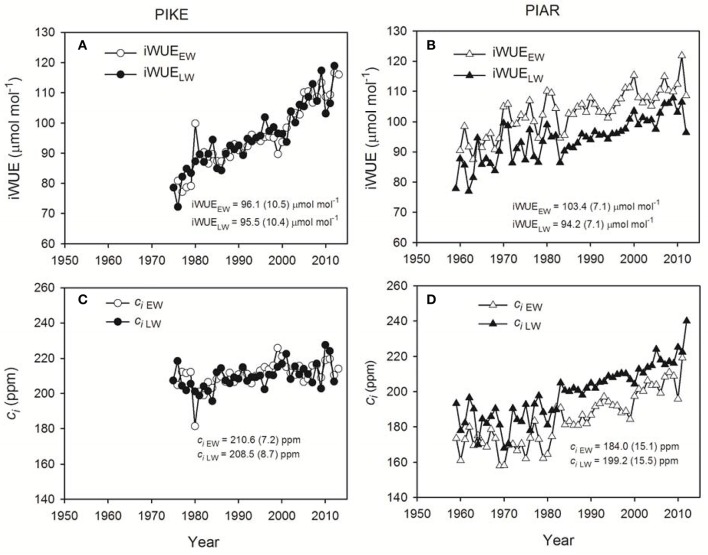
Intrinsic water use efficiency (iWUE) for earlywood (iWUEEW, open circle) and latewood of secondary forest pine P. kesiya (PIKE) (iWUELW, closed circle) (A), and for earlywood (iWUEEW, open triangle) and latewood of natural forest pine P. armandii (PIAR) (iWUELW, closed triangle) (B), intercellular CO2 concentration (ci) of earlywood (ciEW, open circle) and latewood of secondary forest pine P. kesiya (ciLW, closed circle) (C), and for earlywood (ciEW, open triangle) and latewood of natural forest pine Pinus armandii (ciLW, closed triangle) (D). Mean values and standard deviations of iWUE and ci series are indicated inside the panels.